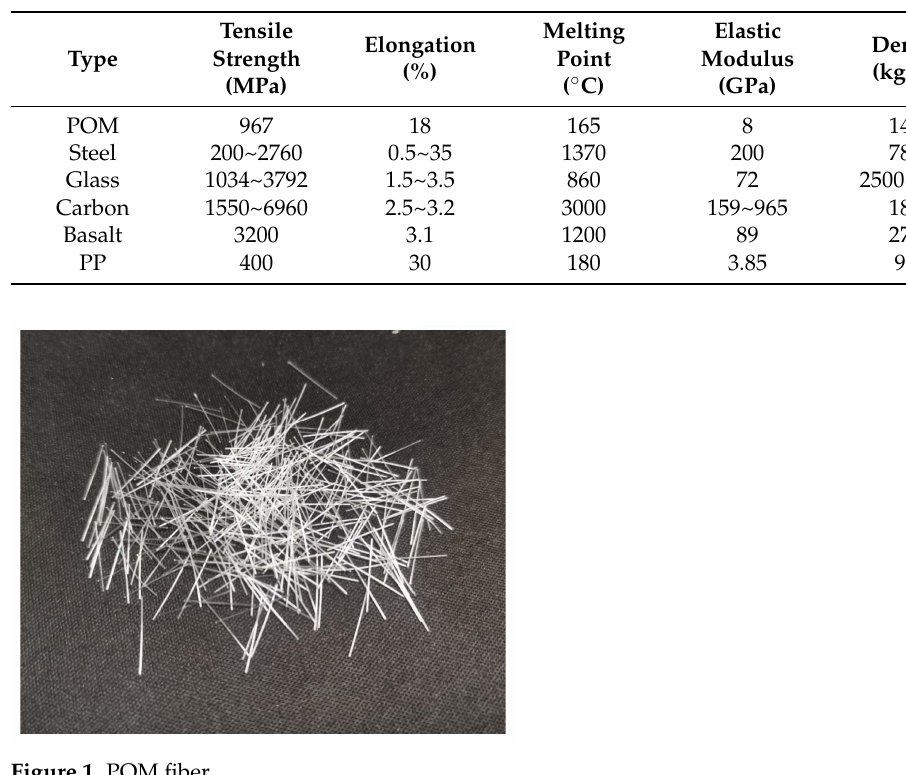
Table 1. Comparison among different fibers [29,34].